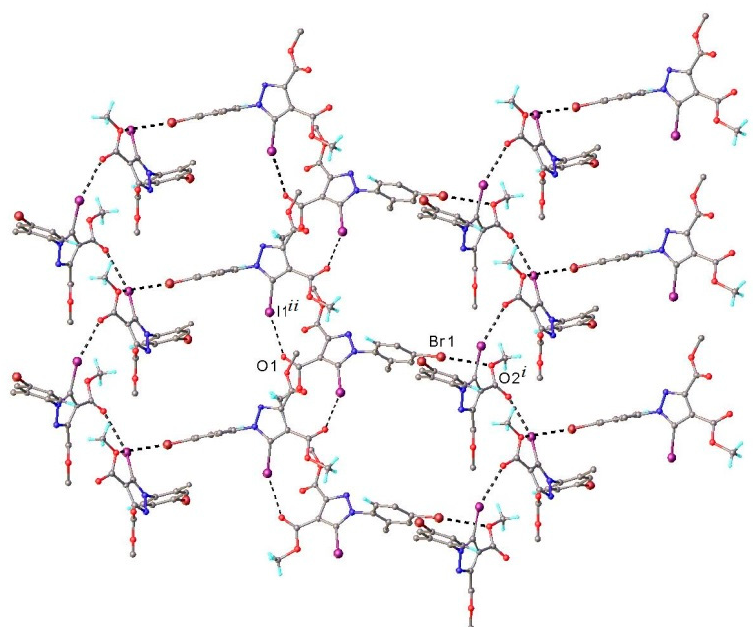
Figure 7. A partial view of 3D network showing C-Br ⋯ O and C-I ⋯ O halogen bonding in the crystal structure of compound 3 . Halogen bond parameters: C8-I1···O1 [C8-I1 2.071(6) Å, I1···O1(2 + x, 1.5 − y, 1 − z) 3.045(5) Å, ∠ C8I1O1 157.5(2)°; C1-Br1···O2 [C1-Br1 1.895(7) Å, Br1---O2(–x, y − 0.5, 1.5 − z) 3.251(5) Å, ∠ C1Br1O2 157.9(3)°.